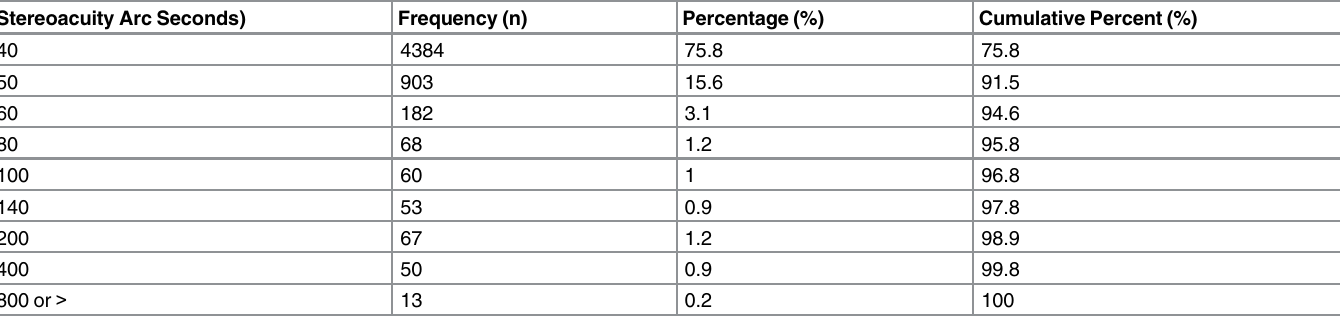
Table 1. Distribution of Stereoacuity in the Shandong Children Eye